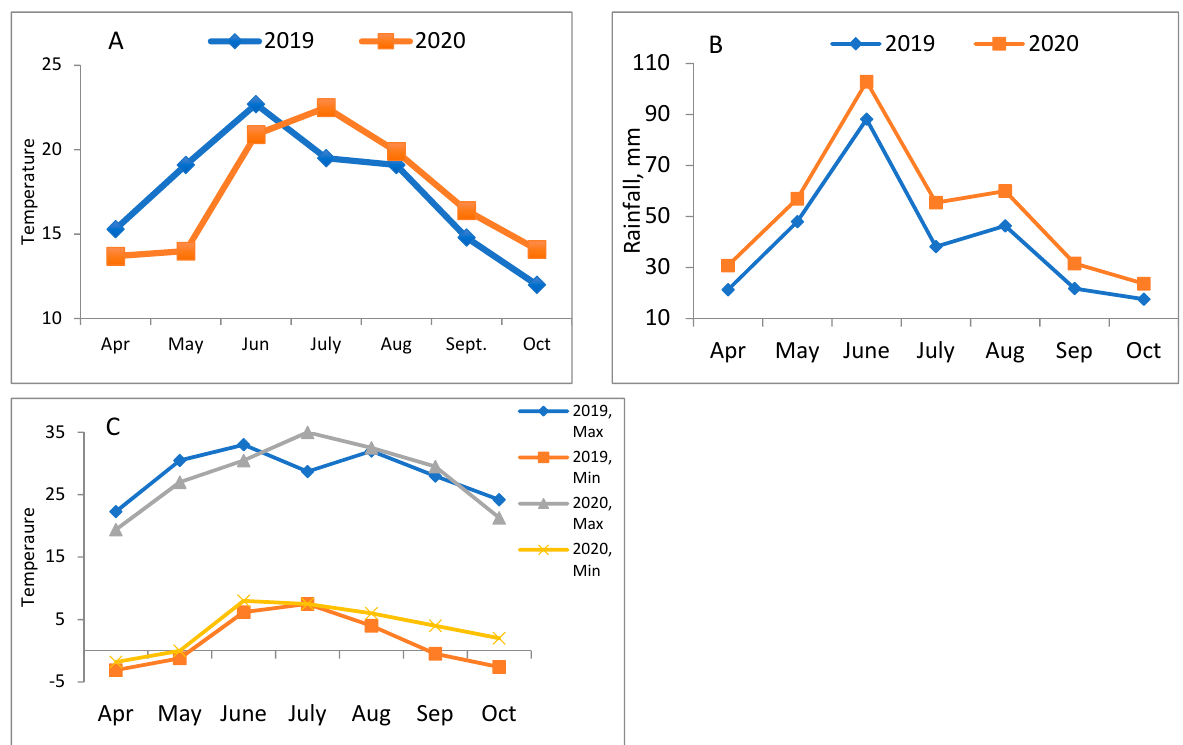
Figure 1. Meteorological conditions (temperature and rainfall) of the growing seasons (2019–2020) in the central region of the Russian Federation (Michelson Observatory, Moscow). ( A ) Average tem-perature; ( B ) average rainfall; ( C ) maximum and minimum temperature.